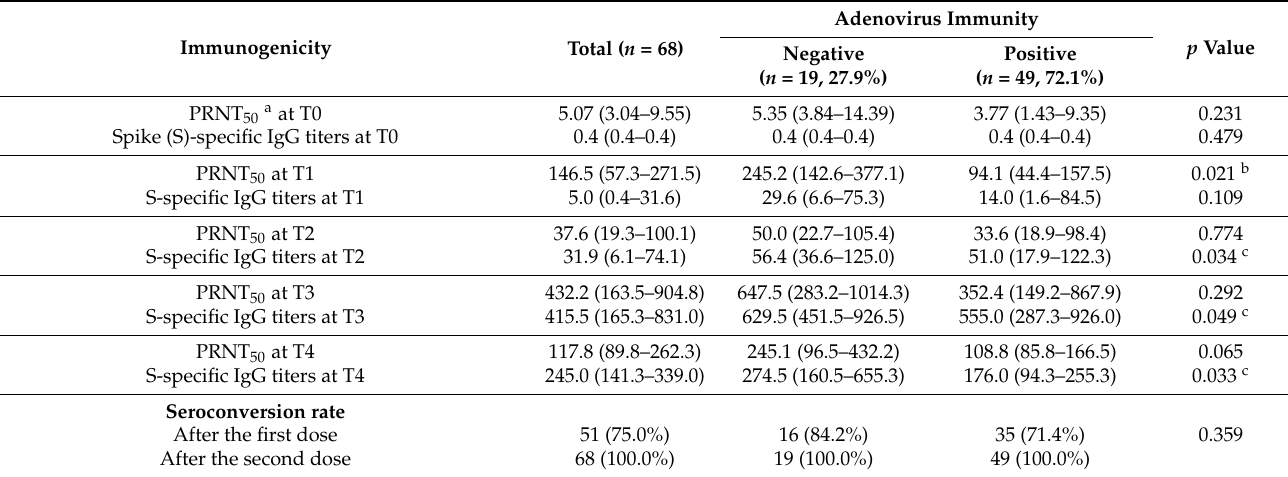
Table 2. Humoral responses of individuals with ChAdOx1 nCoV-19 vaccination according to pre- existing adenovirus